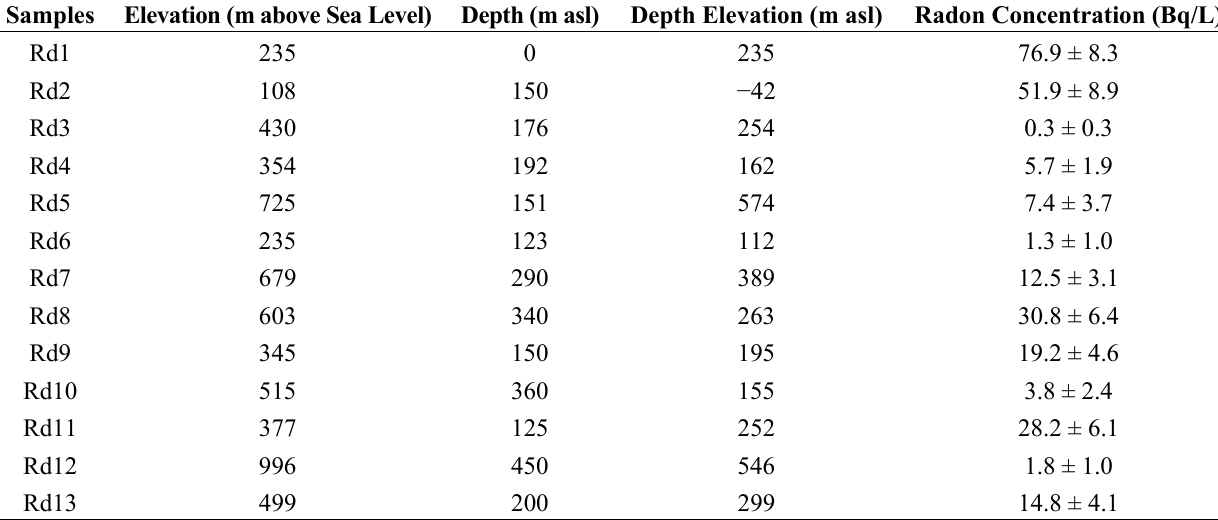
Table 1. Radon activity concentrations in the measured